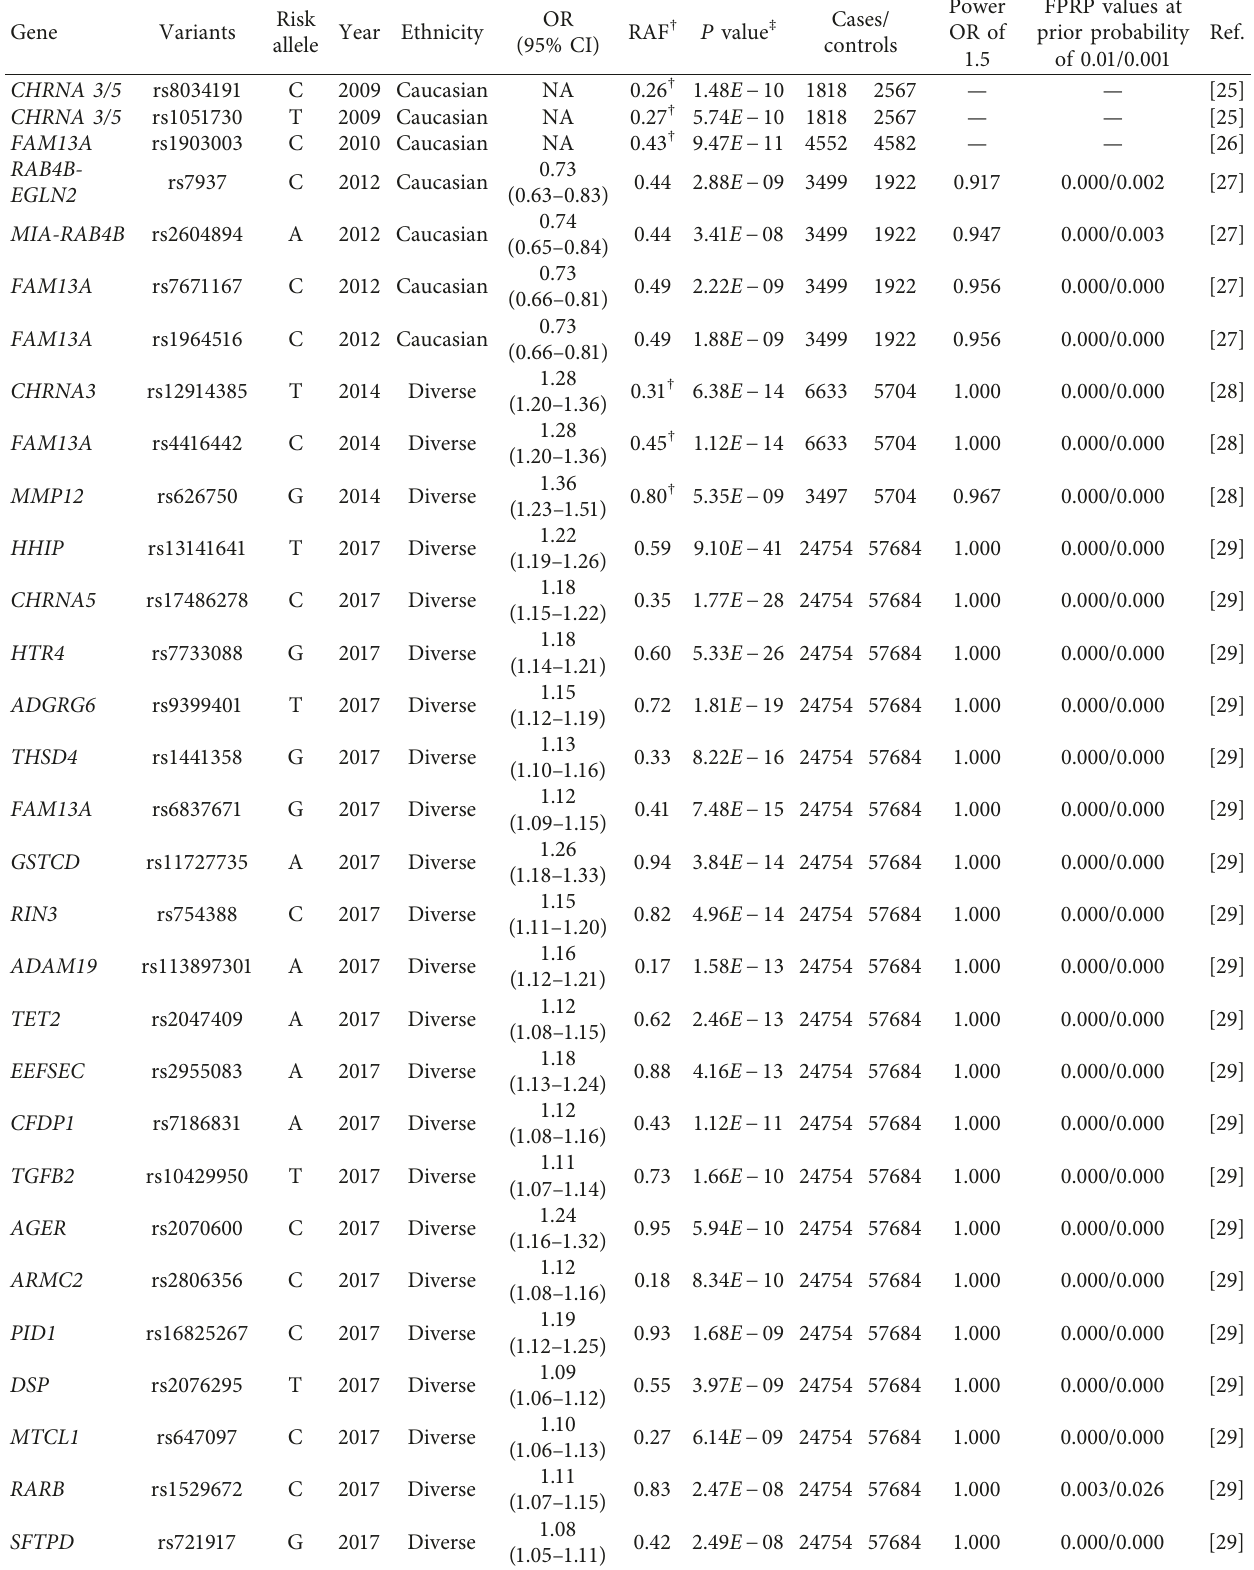
Table 2: Statistically significant variants from